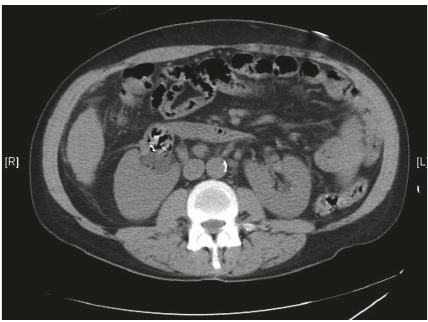
Figure 1: Abdominal CT scan, transverse view. Right renal pelvis collection (with large amount of air and hyperattenuating